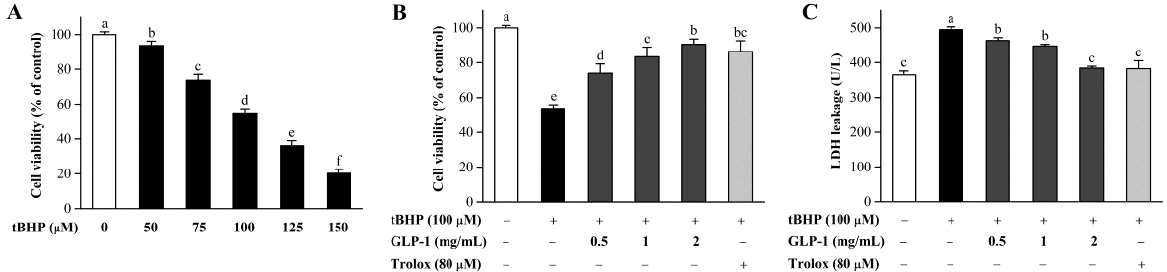
Figure 5. The viability of NIH3T3 cells treated with various tBHP concentrations ( A ). The viability ( B ) and LDH leakage ( C ) of NIH3T3 cells treated with different GLP-1 concentrations or Trolox and co-cultured with 100 µ M of tBHP. Data are presented as mean ± S.D. Values with different letters (a–f) denote the significant differences ( p < 0.05).